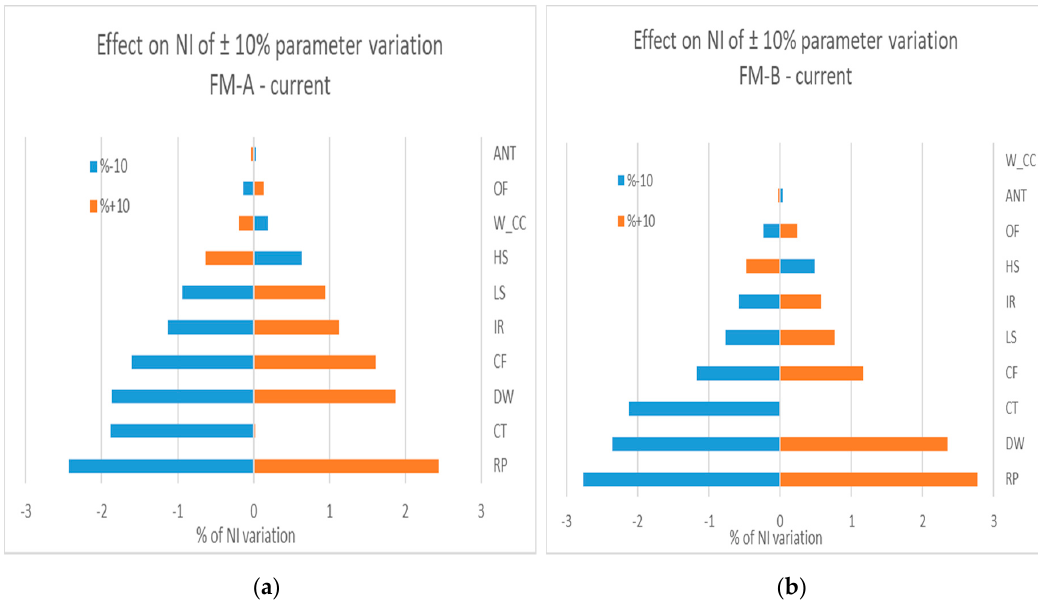
Figure 3. Results of the sensitivity analysis testing a variation of 10% of the parameter value on